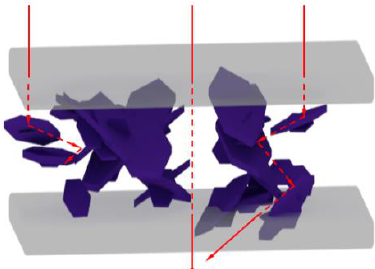
Figure 9. Schematic diagram of the barrier of α -Al 2 O 3 to injected charge in the XLPE matrix.